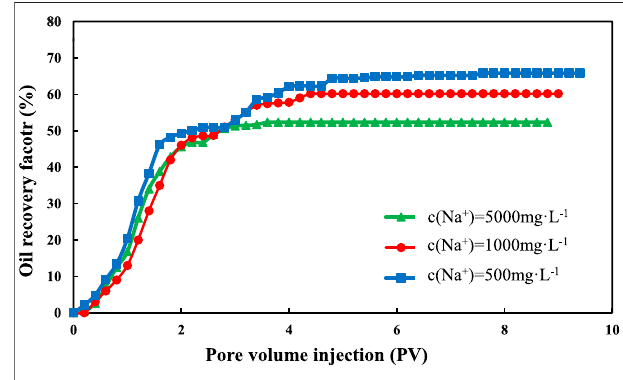
FIGURE 3 | Oil recovery of montmorillonite sand packs of different salinity of NaCl.